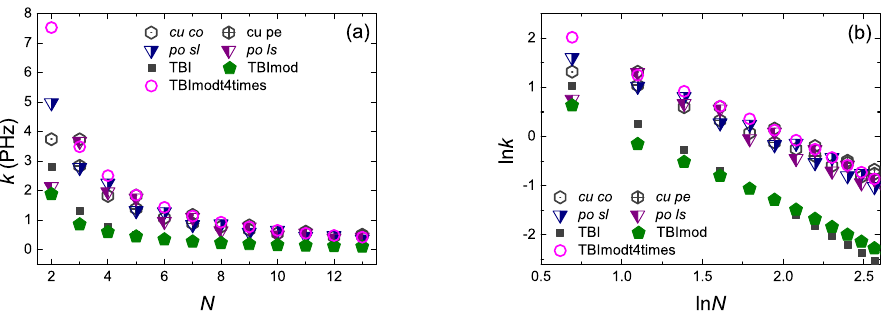
Figure 16. Transfer rates along carbyne wires as obtained by RT-TDDFT at the B3LYP/cc-pVTZ level of theory as well as by TBI, TBImod and TBImodt4times: cu co (dark gray hexagons with dot), cu pe (dark gray hexagons with cross), po sl (blue right half-filled down triangles), po ls (purple left half-filled down triangles), TBI (black squares), TBImod (olive pentagons), TBImodt4times (magenta circles). ( a ) k ( N ) , ( b ) ln k ( ln N ) .